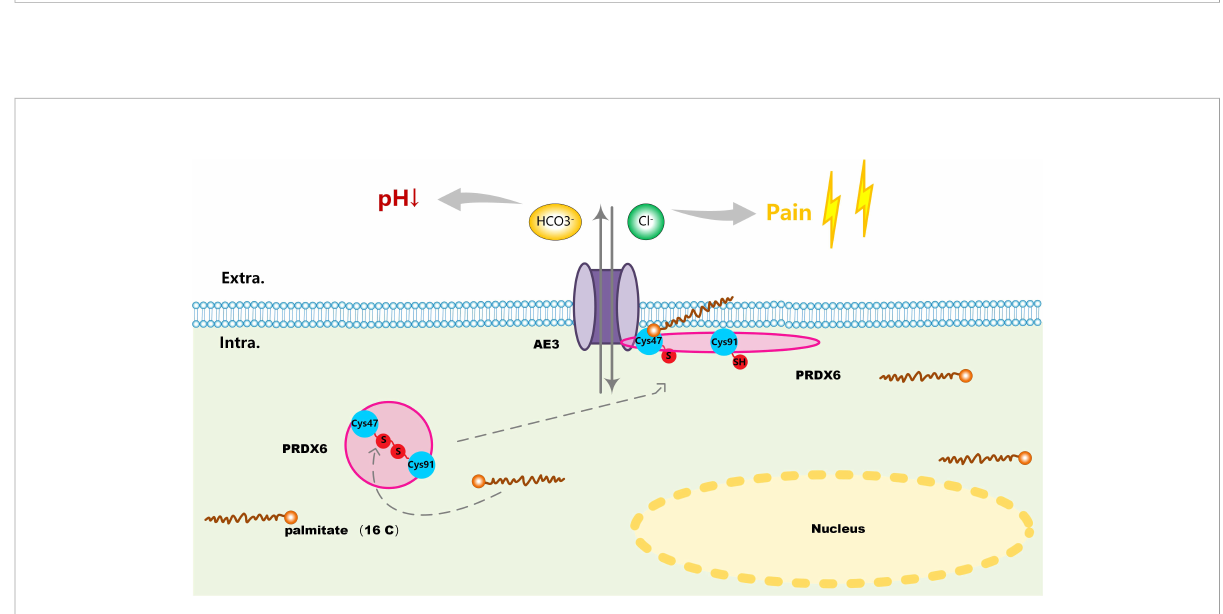
FIGURE 6 A schematic of the involved molecular mechanism that S-palmitoylation mediated reduction of disul fi de bond (Cys47-Cys91) on PRDX6 activated its interaction with AE3 and induced its translocation from the cytoplasm to the plasma membrane. PRDX6-AE3 interaction enhanced the Cl - in fl ux and HCO3 - extra fl ux, causing pain and decline of pH in